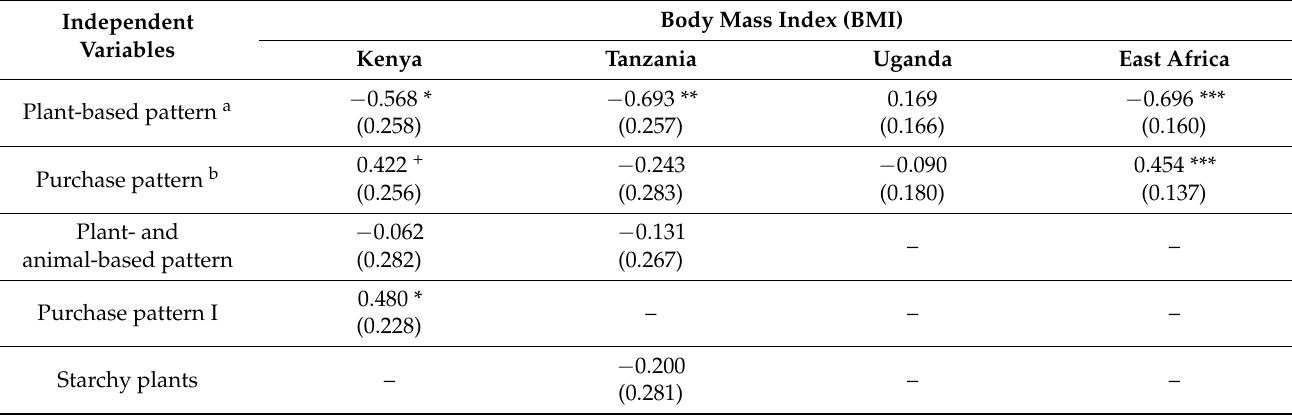
Table 8. Relationship between extracted patterns and body mass index (BMI) of women of reproductive age in rural Kenya, Tanzania, Uganda, and East